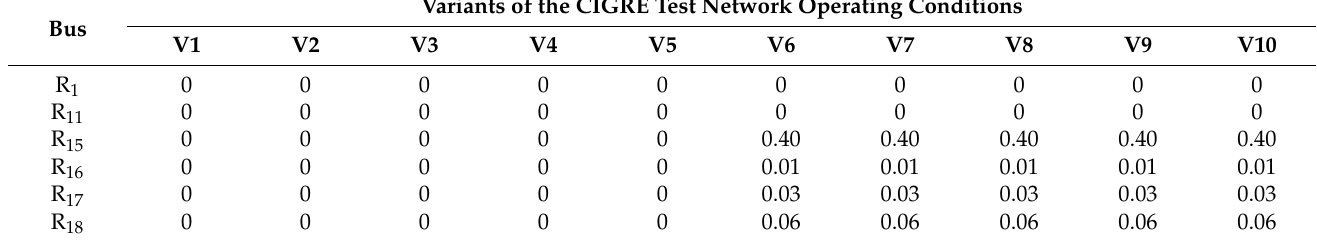
Table 7. The risk of exceeding the upper limit of the negative sequence component of the bus voltage R S (%) for load buses in the CIGRE test network. V 2